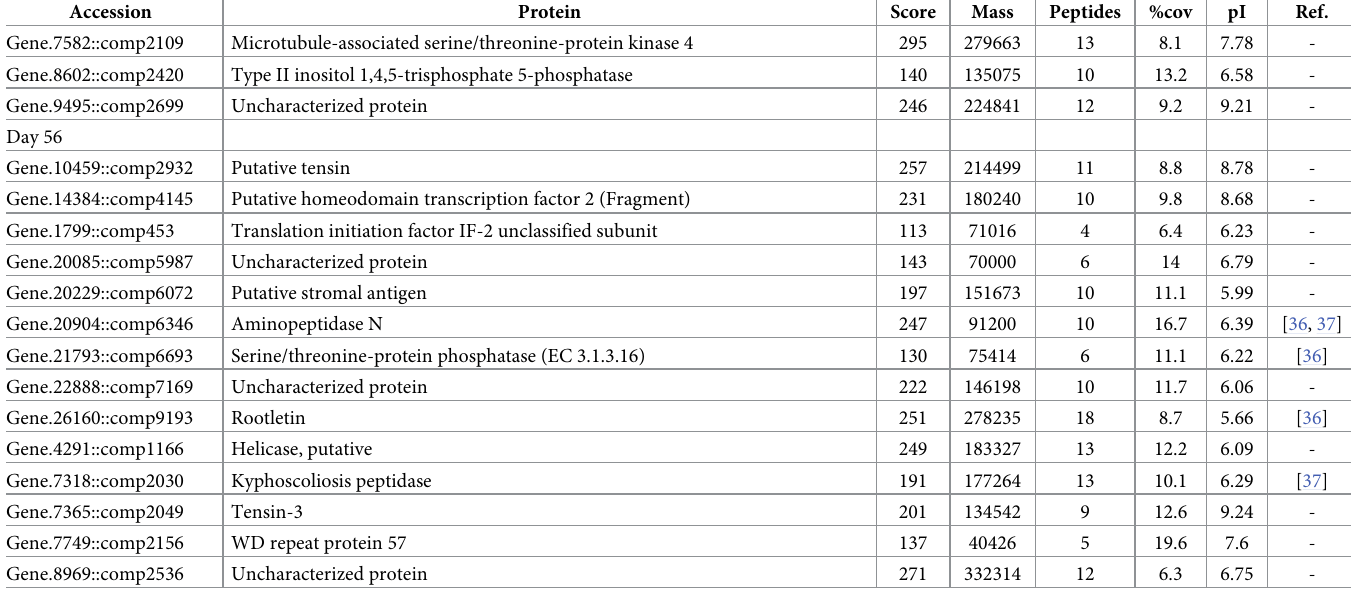
antibodies in mouse blood. Compared with uninfected sera, the infected sera showed 55 and 26 kDa protein bands of significantly increased intensity. Thus, gels 5 and 7 were analyzed and identified using mass spectrometry and the UniPlot protein database. As expected, no S